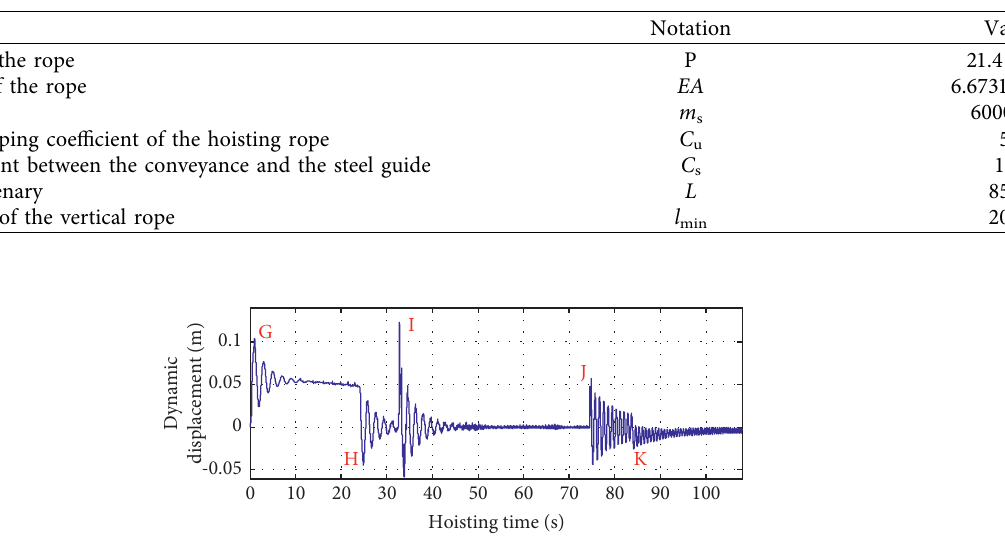
Table 2: Hoisting parameters of a superdeep mine hoist.